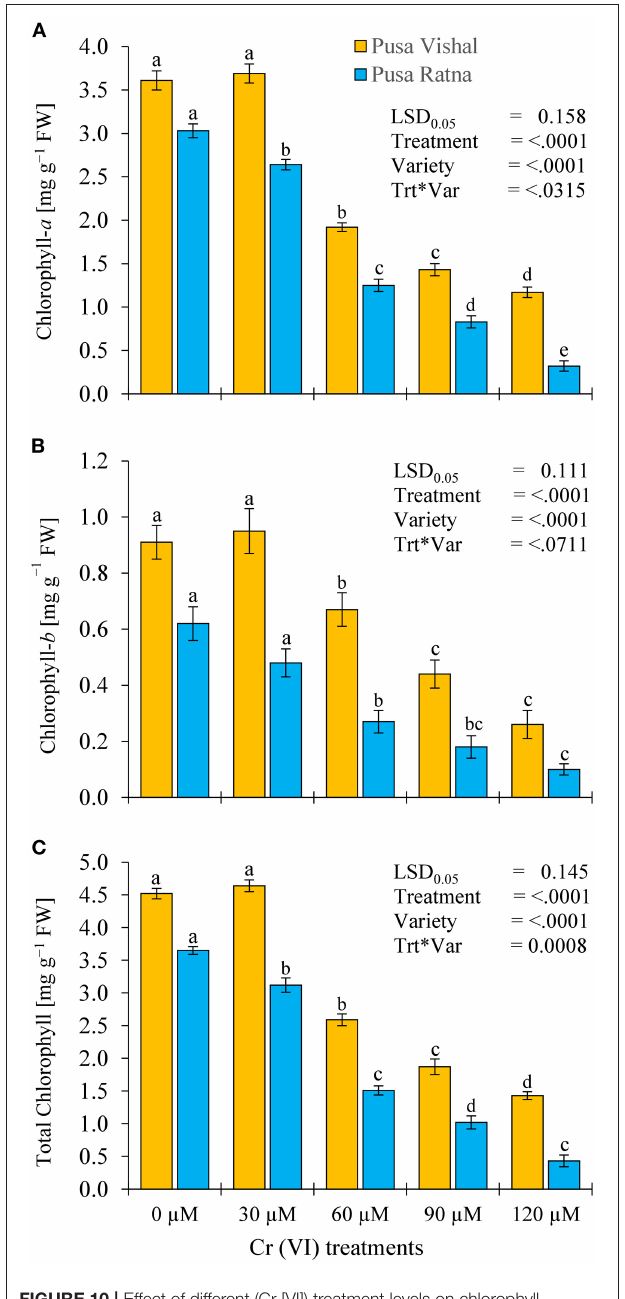
FIGURE 10 | Effect of different (Cr [VI]) treatment levels on chlorophyll contents (mg · g − 1 FW): (A) Chlorophyll- a , (B) Chlorophyll- b , and (C) Total Chlorophyll, in two Mungbean cultivars, Pusa Vishal (PV) and Pusa Ratna (PR) 35 days after sowing, in pot conditions. Mean values of three replicates are shown; error bar ( ± standard error [SE]). Mean values with the same letter don’t have significant difference at p ≤ 0.05 according to the Least Significant Difference test (LSD 0.05